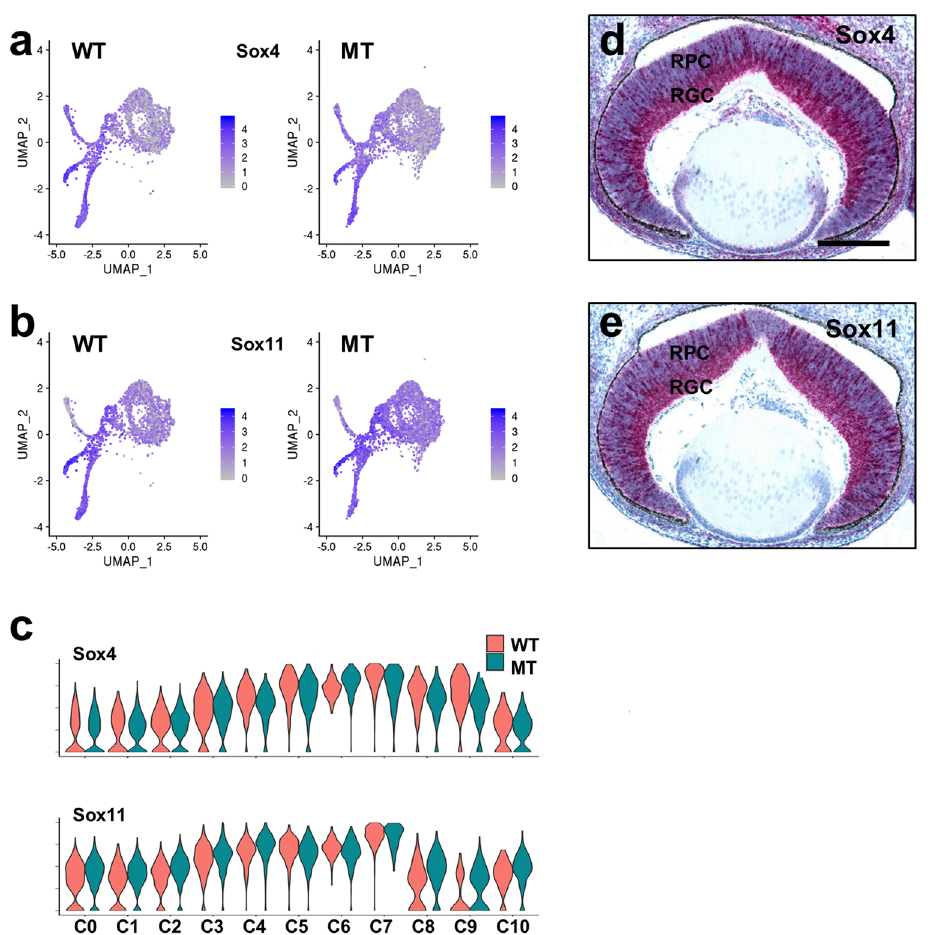
Fig. 5 Spatial expression of Sox4 and Sox11 . a , b Feature plot heatmaps indicate that both genes are expressed in all clusters but at much higher levels in differentiating cells, and that their expression levels are comparable in wild-type (WT) and Atoh7 -null (MT) cells. Color scales represent natural-log transformed normalized gene expression levels as described in “ Methods ” . c Violin plots indicate that both genes are expressed in comparable levels in corresponding WT (red) and MT (blue) clusters. The heights of the plots represent expression levels as described in “ Methods ” and the widths represent relative proportions of cells expressing the gene at that level. d , e In situ hybridization with RNAscope probes con fi rms that Sox4 and Sox11 are expressed in both retinal progenitor cells (RPCs) and retinal ganglion cells (RGCs). Note that both genes are highly expressed in a subset of RPCs in the outside part of the retina, which presumably are the transitional RPCs. Each in situ hybridization experiment was performed three times with independent retinal sections. The scale bar is 150 µ